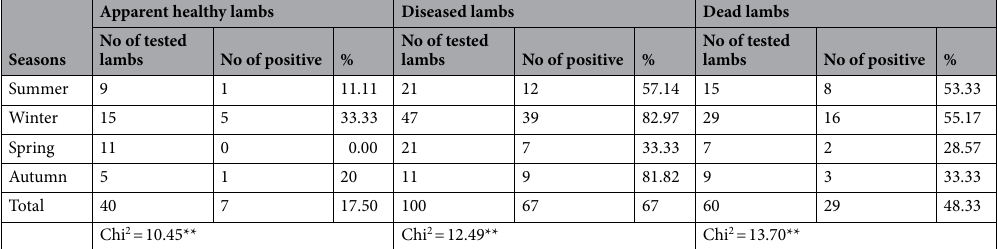
Table 1. Prevalence of C. perfringens in different examined lambs in relation to season. ** = Significant at ( P < 0.01).